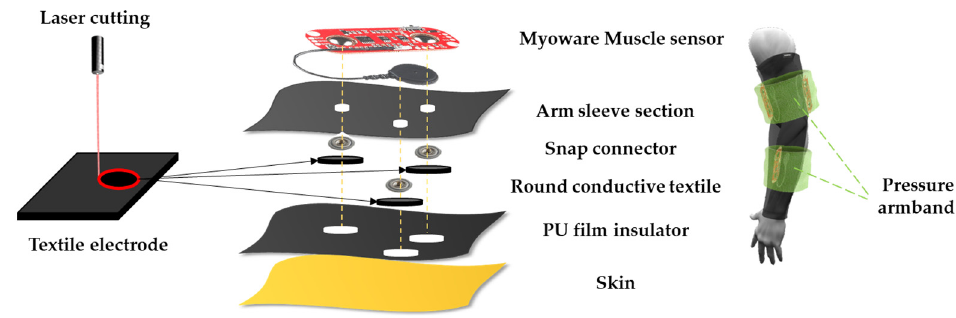
Figure 4. Arm sleeve device design.